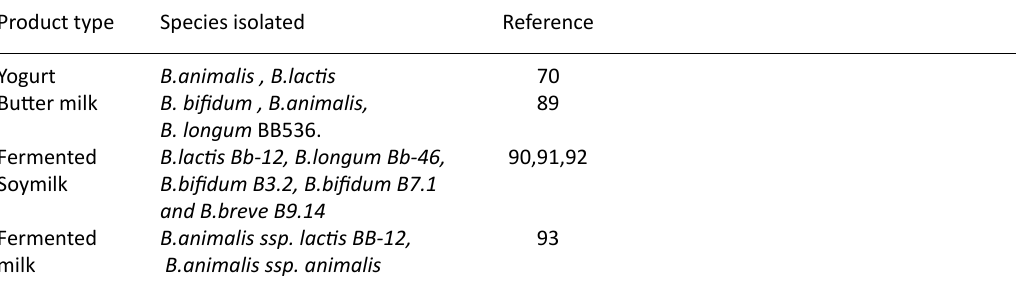
Table 5. Bifidobacterium species isolated from different food products Product